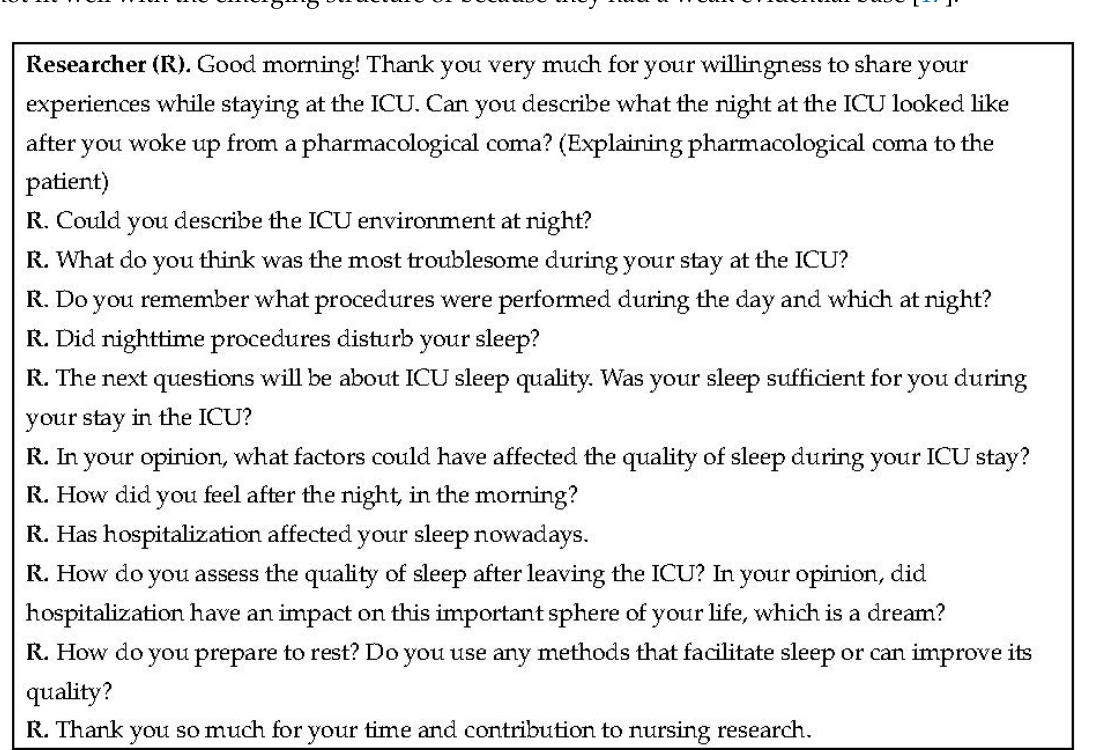
Figure 2. Interview using a questionnaire comprising of ten questions.